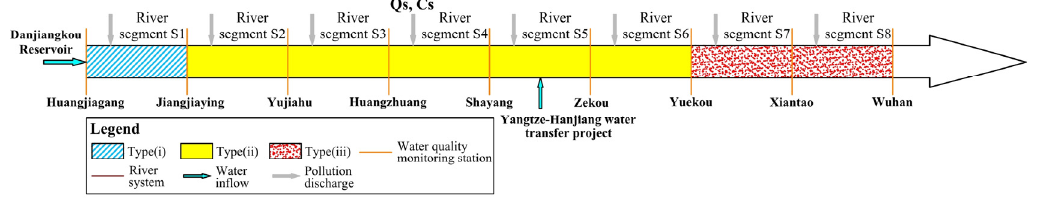
Figure 10. Three types of river segments along the main stream of the mid-lower reaches of the Hanjiang River.